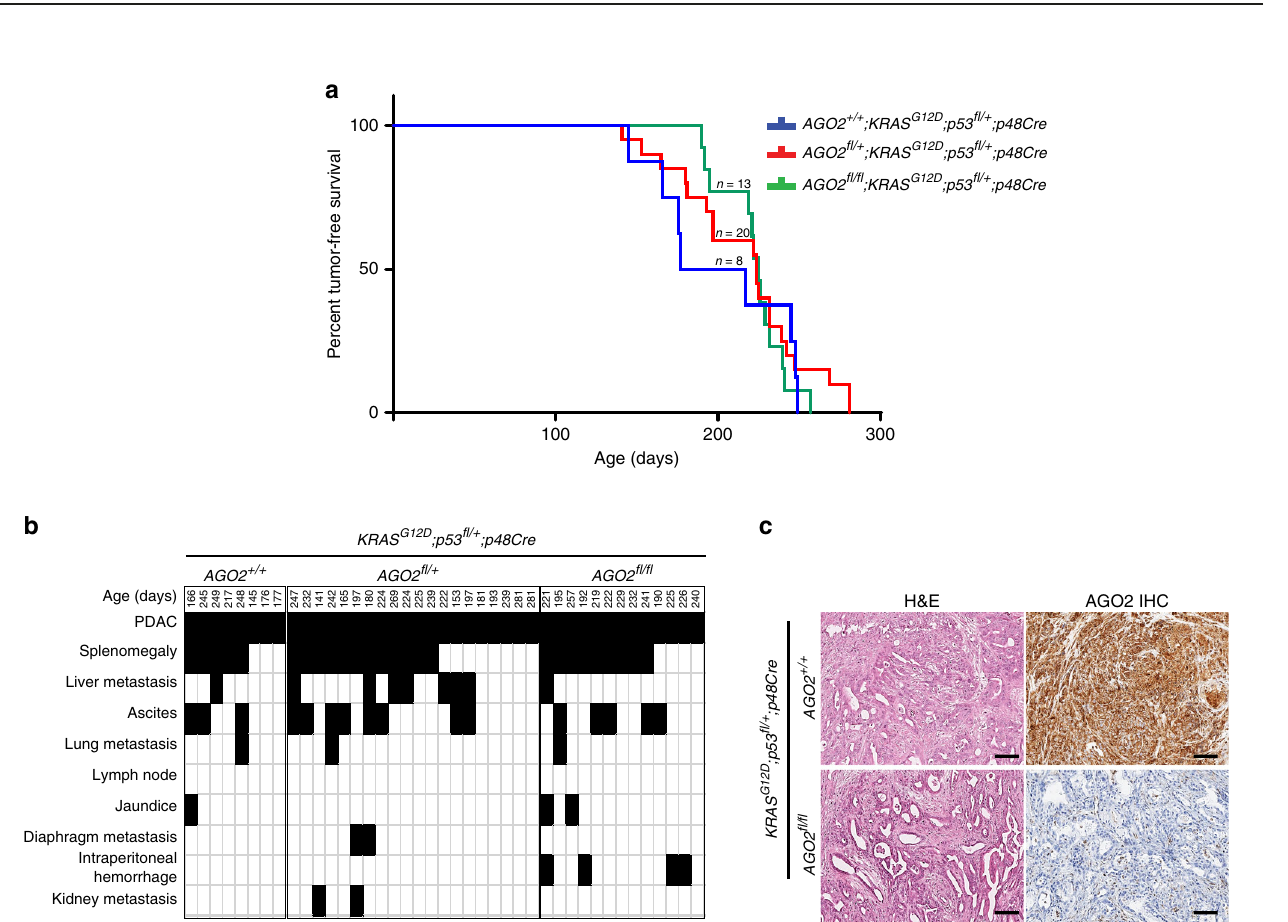
Fig. 3 p53 loss bypasses requirement for AGO2 during PDAC progression. a Kaplan – Meier tumor-free survival of AGO2 + / + ;KRAS G12D ;Trp53 fl / + ;p48Cre , AGO2 fl / + ;KRAS G12D ;Trp53 fl / + ;p48Cre , and AGO2 fl / fl ;KRAS G12D ;Trp53 fl / + ;p48Cre mice. b Chart showing PDAC (within the pancreas), the different metastatic lesions, and abnormal pathologies (black boxes) observed in each mouse of the indicated genotypes. c Representative H&E and AGO2 IHC in the indicated genotype. Scale bar, 100 µ